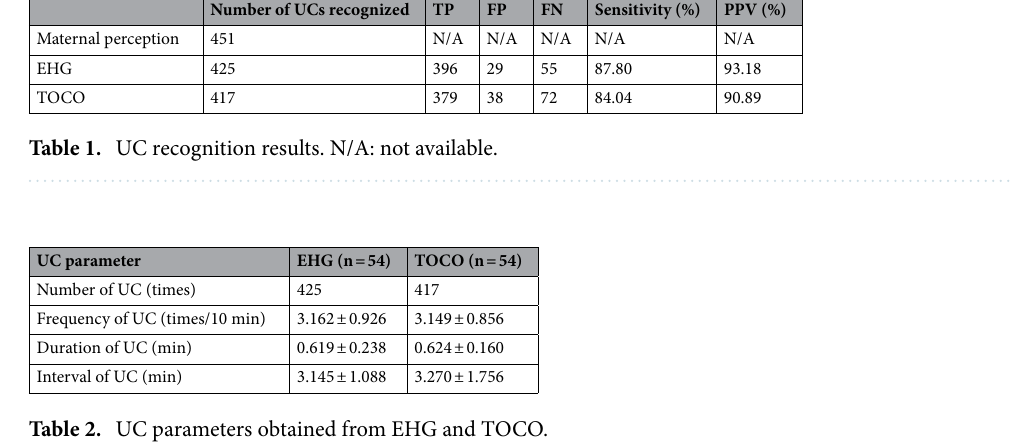
Table 2. UC parameters obtained from EHG and